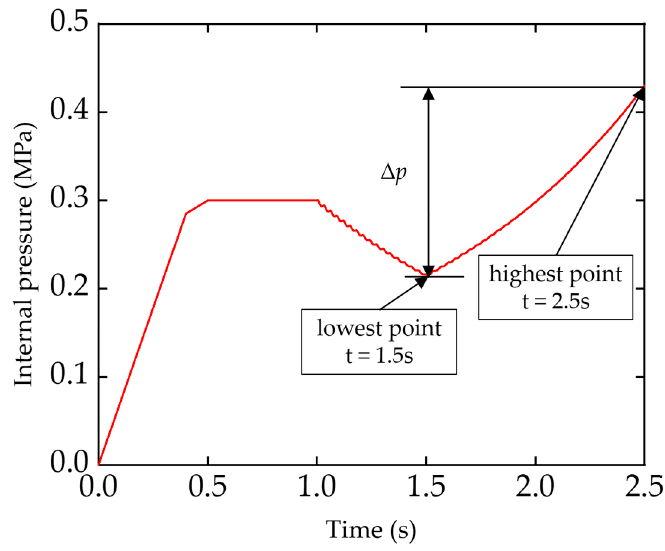
Figure 6. The internal pressure at different times.